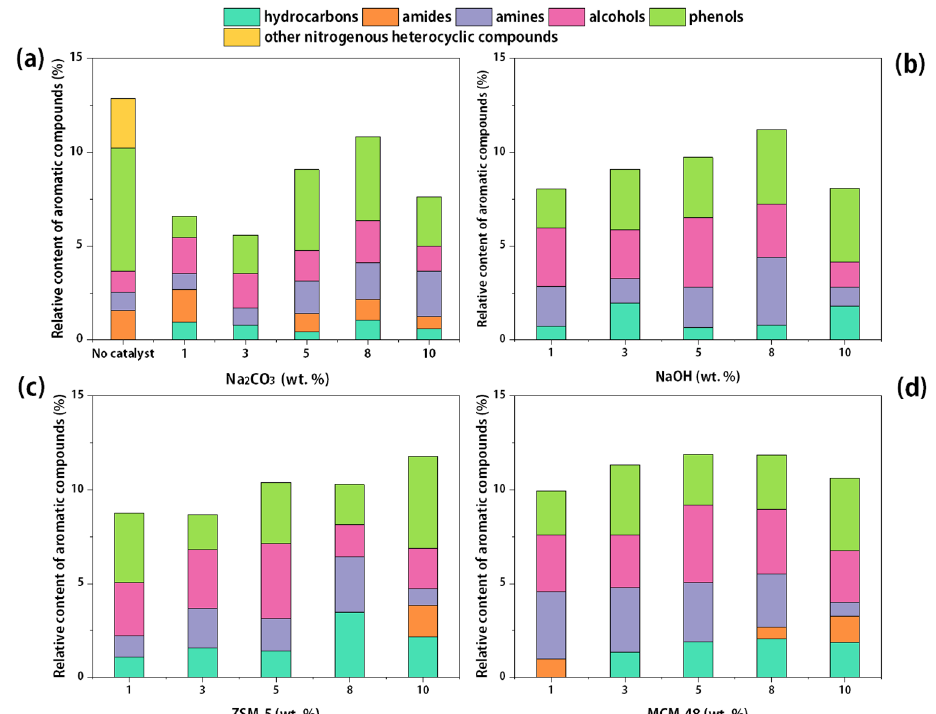
Figure 5. Aromatic compound distribution in PR bio-oil: ( a ) Na 2 CO 3 , ( b ) NaOH, ( c ) ZSM-5, ( d ) MCM-48.